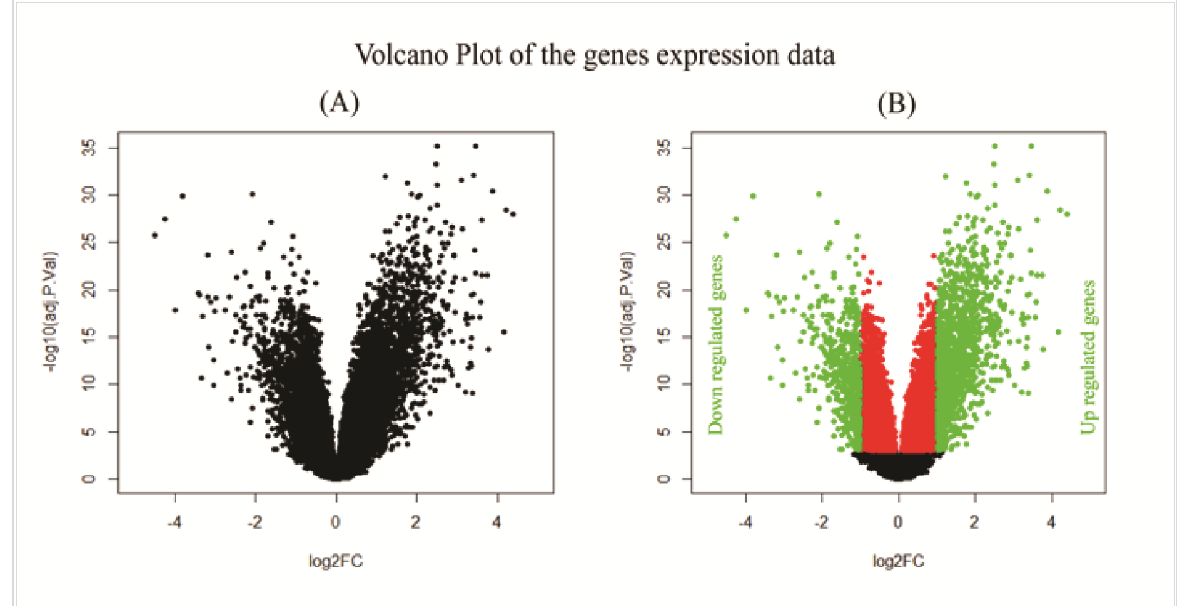
Figure 2. Gene expression profile of microarray data. ( A ) The volcano plot which represents the scatter plot of log 2 FC values versus − log 10 (adjusted p -values). ( B ) The volcano plot highlighting DEGs, where green bullets represent the upregulated (adjusted p -value < 0.001 and log 2 FC > 1) and downregulated (adjusted p -value < 0.001 and log 2 FC < − 1) DEGs selected based on the described criteria.